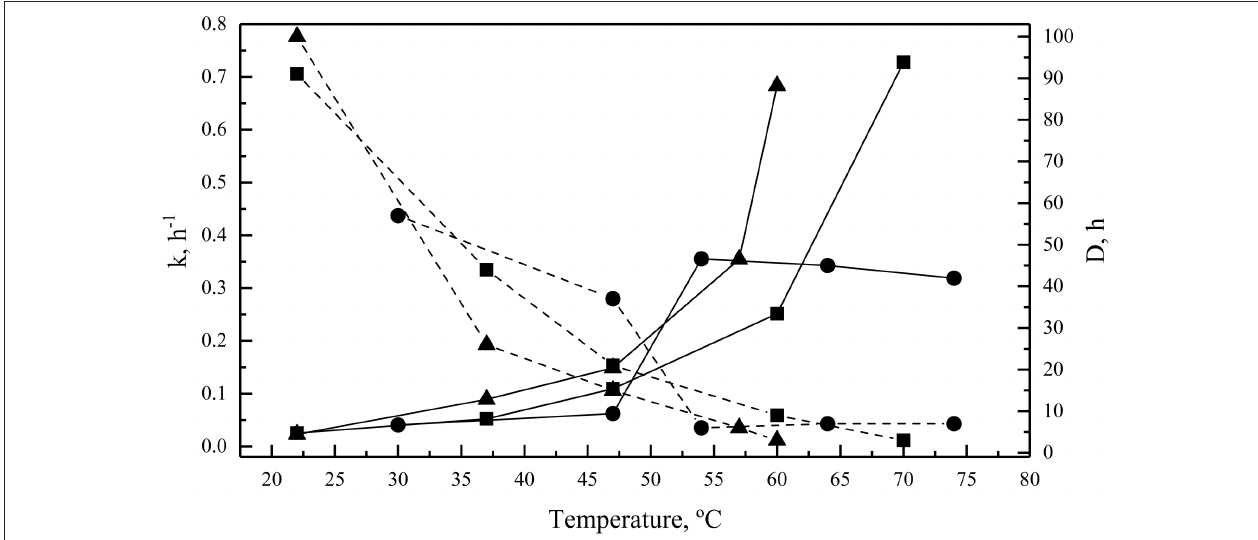
FIGURE 5 | Enzyme thermal inactivation. The inactivation rate constant ( k , continuous lines) and D -values (discontinuous lines) are shown for GOD (circles), Inv (squares), and ALP (triangles). The total amount of enzyme used in each assay was 15, 39, or 39 ug of GOD, Inv or ALP, respectively; the substrate concentration used was 280, 100, or 5mM of glucose, sucrose or pNPP,